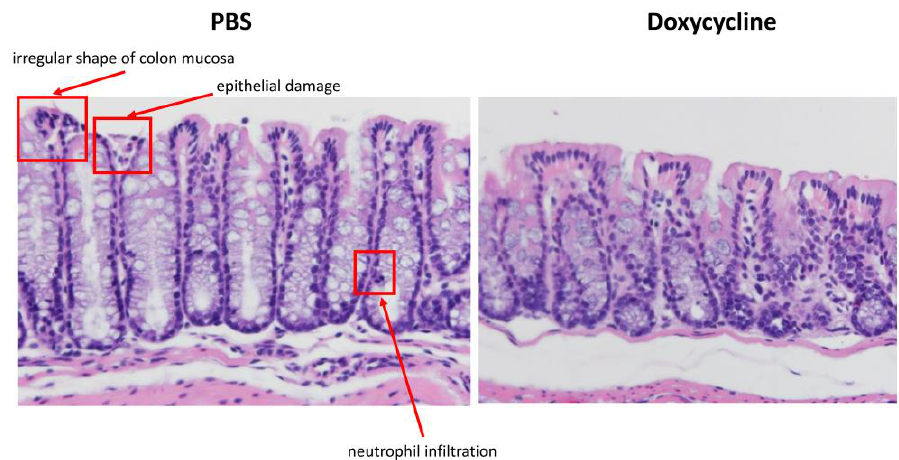
Figure 3. Epithelial inflammation (neutrophil infiltration, epithelial damage, and irregular shape of colon mucosa) in mice receiving phosphate-buffered saline (PBS) or doxycycline followed by oral challenge with Clostridioides difficile. Hematoxylin and eosin staining of resected colons in the PBS and doxycycline groups (magnification 400 × ).